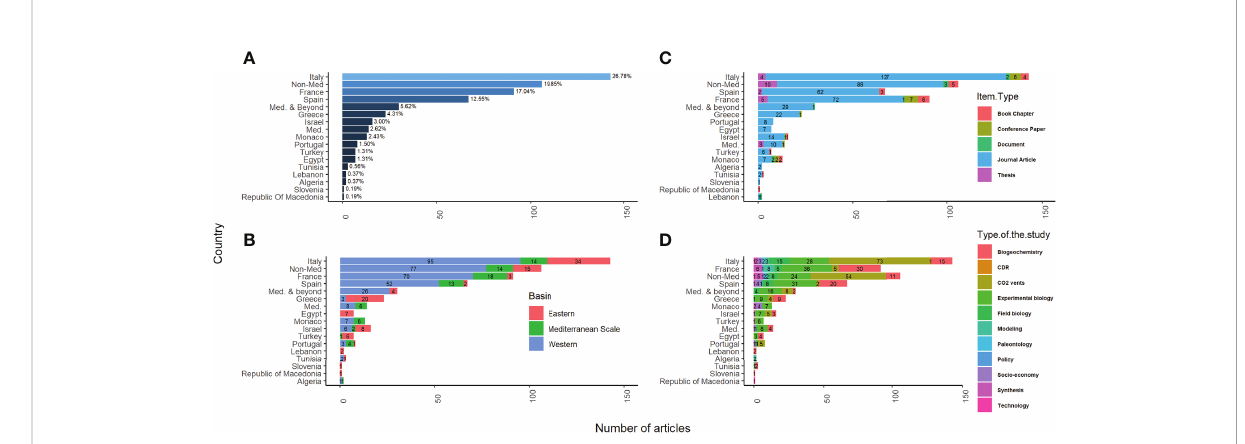
FIGURE 3 Productivity of OA-related studies: (A) per country* and groups, (B) per type of the OA-related items, (C) per the geographic location of the study, (D) per type of the tackled OA-related topic. Articles published by multiple Mediterranean countries are referred to as “ Med. ” , by Mediterranean and non-Mediterranean countries as “ Med. & Beyond ” , and by non-Mediterranean countries as “ Non-Med. ” . *Per country corresponds to the number of OA items published by the 1 st /corresponding author(s) af fi liated to institutions in a speci fi c country or